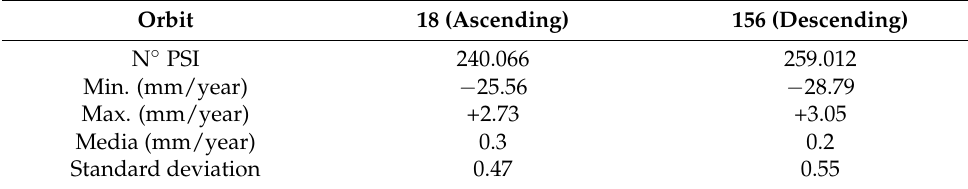
Table 2. Basic PSI statistical comparison for ascending and descending